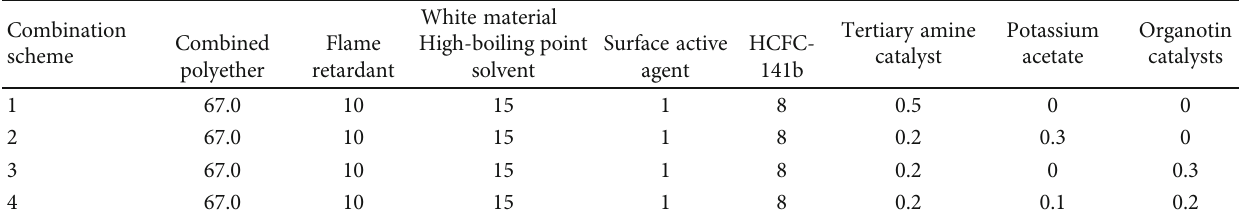
Table 4: Experiment scheme of catalyst combination (%).